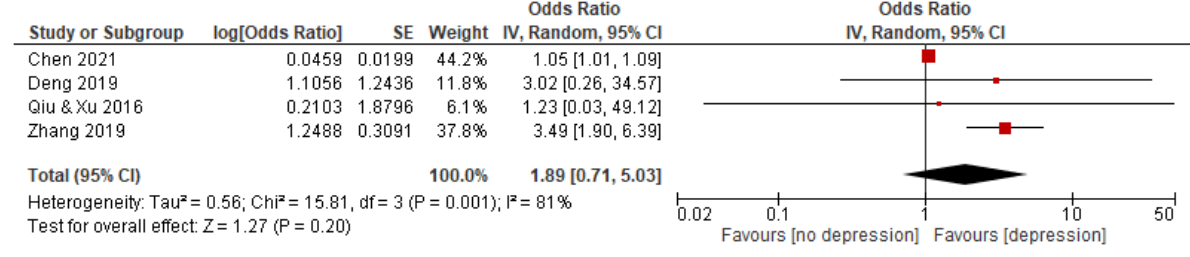
Figure 4. Forest plot of studies on association between YADC and depression. Note: red square represents the result of each study; line represents the 95% CI of the results; diamond represents the pooled results.